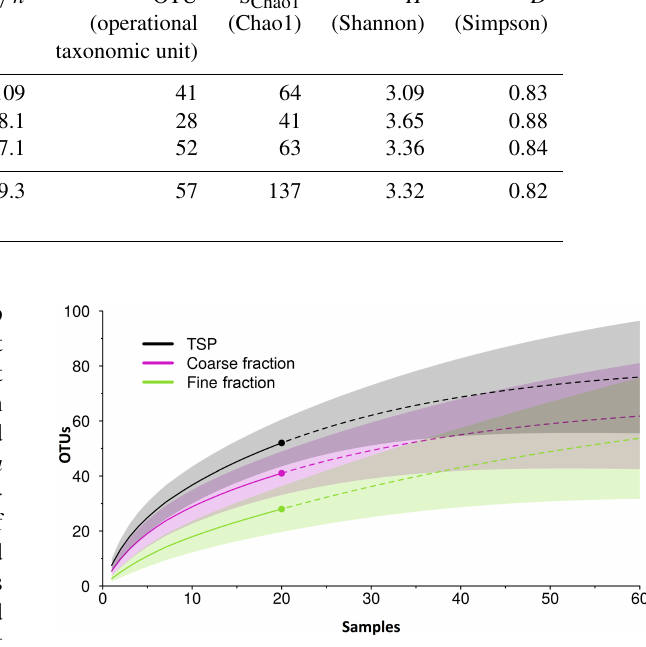
Figure 2. Rarefaction curve of species richness for total suspended (TSP), coarse, and fine particulate matter. TSP is a single airstream split into coarse and fine particulate matter. The solid curves rep- resent the interpolated number of OTUs as a function against the number of samples. The dashed lines represent the extrapolations and the dots the sample size of this study. The colored areas repre- sent the 95% confidence